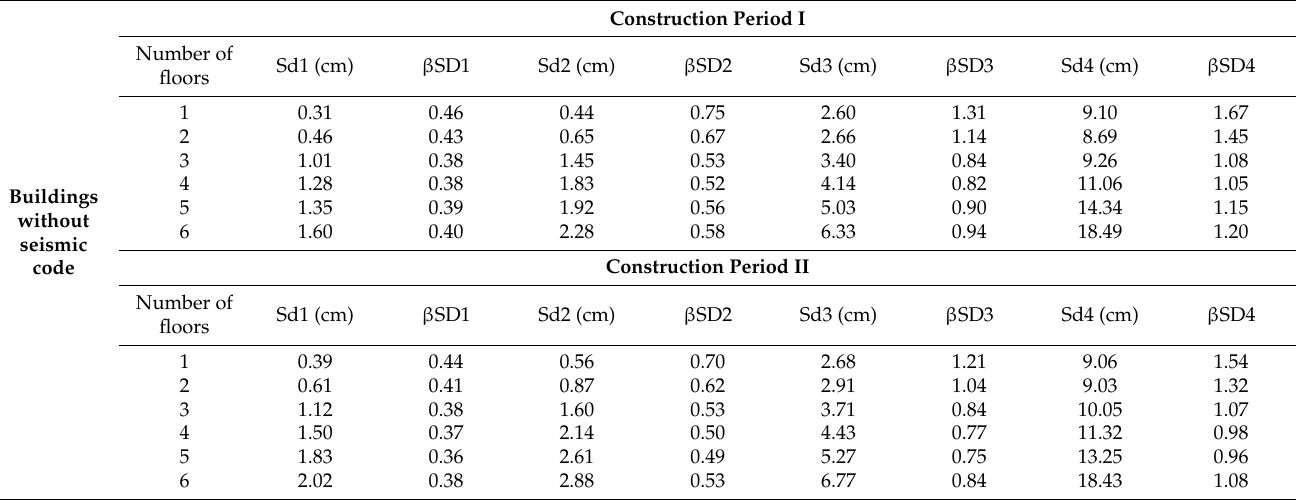
Table A3. Parameters characterizing the fragility curves for the building